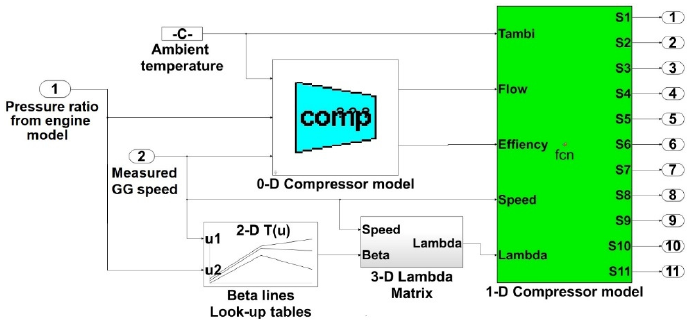
Figure 6. Interface between 0-D and 1-D compressor models in the Simulink environment.